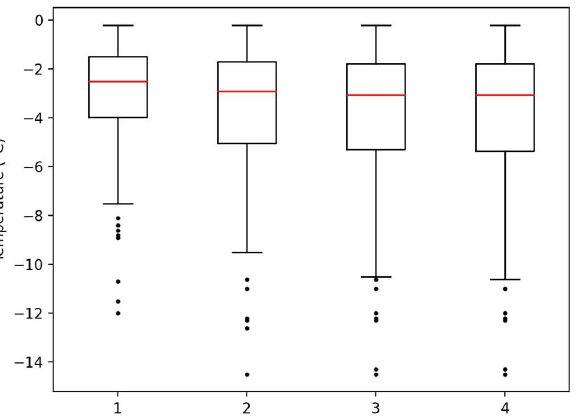
Figure 6. Box-and-whiskers diagram of temperature change with n = 1, 2, 3 and 4 of all cold events. Table 4. The 50th, 25th and 10th percentiles of values for n-day temperature change for all cold events (in °C).